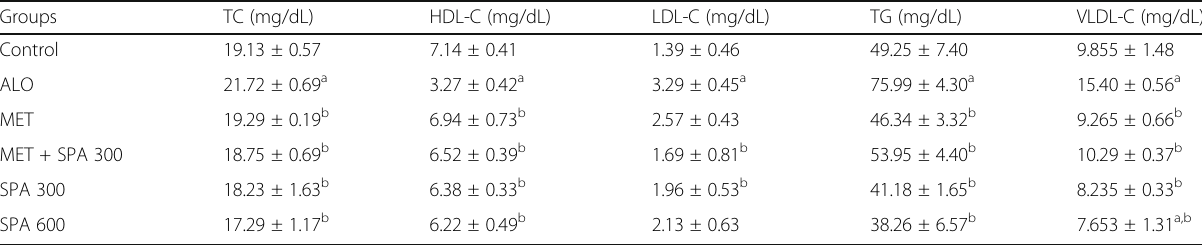
Table 2 Effect of methanol extract of S. sparganophora leaves on lipid profile of alloxan-induced hyperglycemic rats